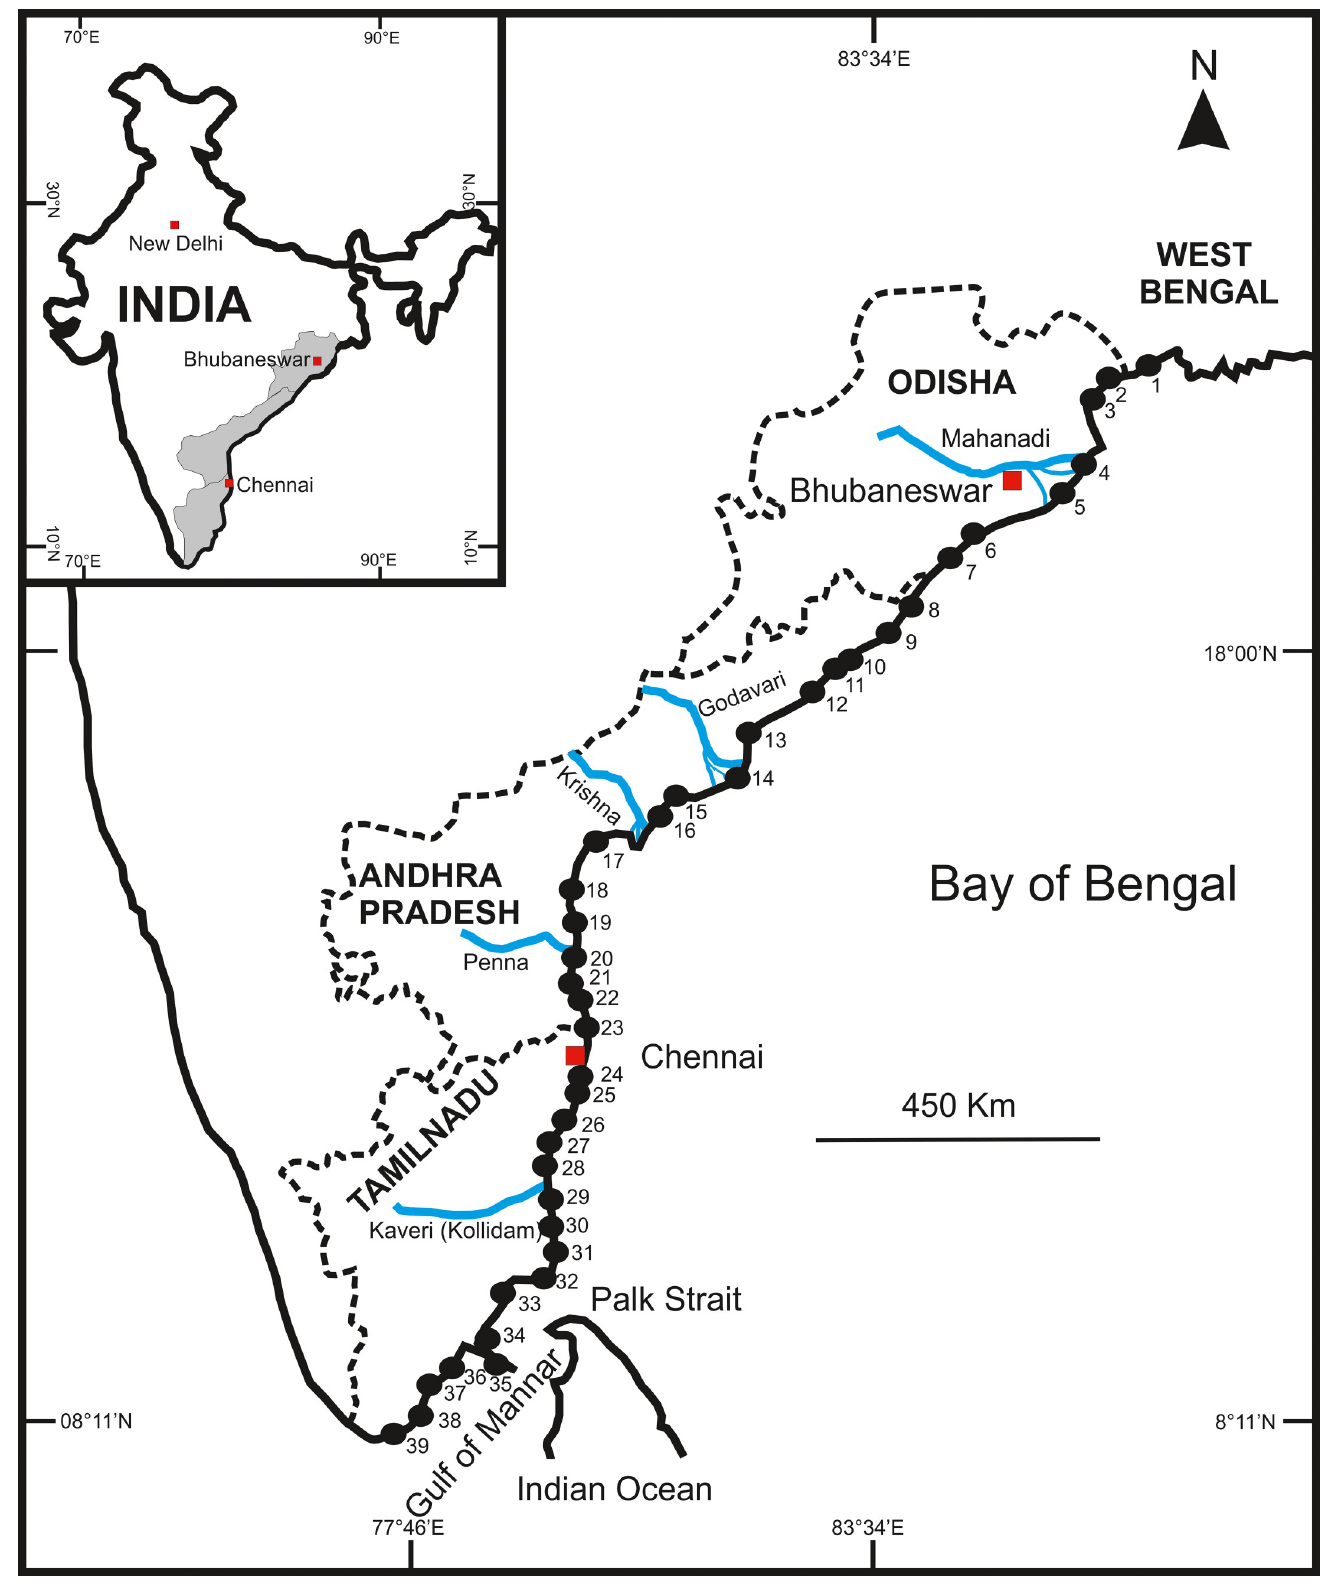
Fig 1. Regional map showing all sampling locations. For details about location numbers, see S1 Appendix. Inset = map of India. https://doi.org/10.1371/journal.pone.0256685.g001 PLOS ONE | https://doi.org/10.1371/journal.pone.0256685 August 26,